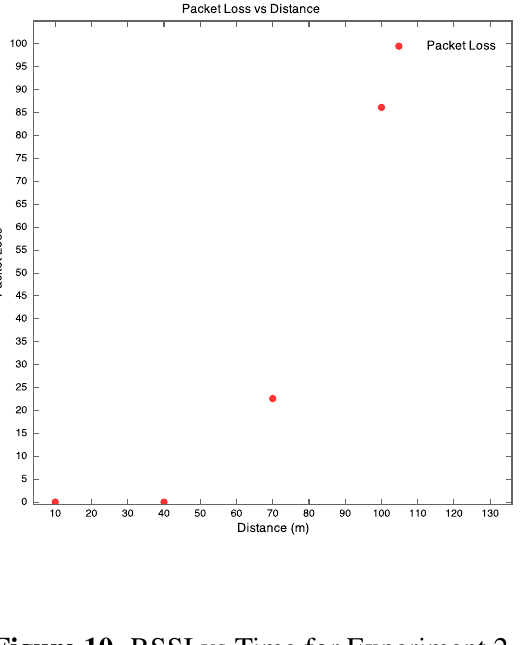
Figure 10. RSSI vs Time for Experiment